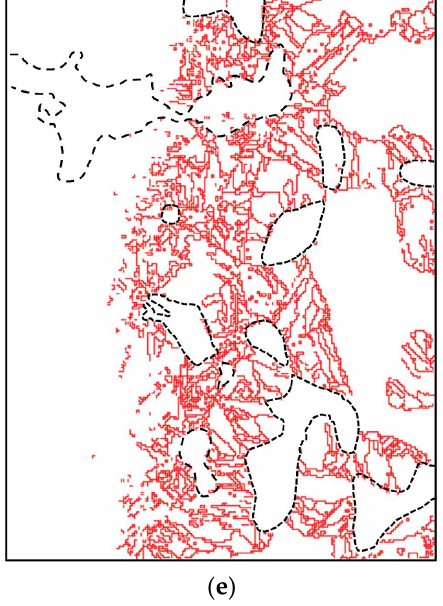
Figure 7. EBSD results of the 410/304L interface. ( a ) Image quality map; ( b ) phase map; ( c ) crystal orientation map of FCC structure; ( d ) crystal orientation map of BCC/BCT structure; ( e ) map of low-angle grain boundary in BCC/BCT structure.